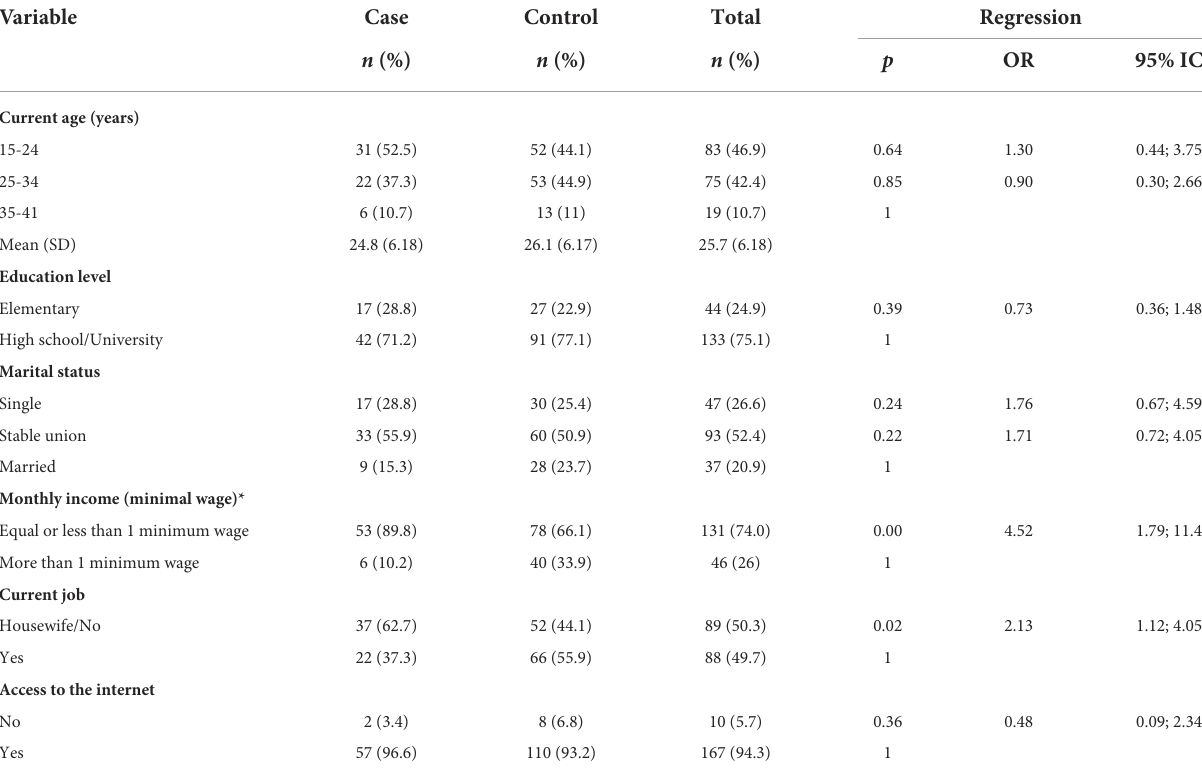
TABLE 1 Sociodemographic factors associated with gestational syphilis, in the Brazilian Amazon, 2020–2021. Variable Case Control Total